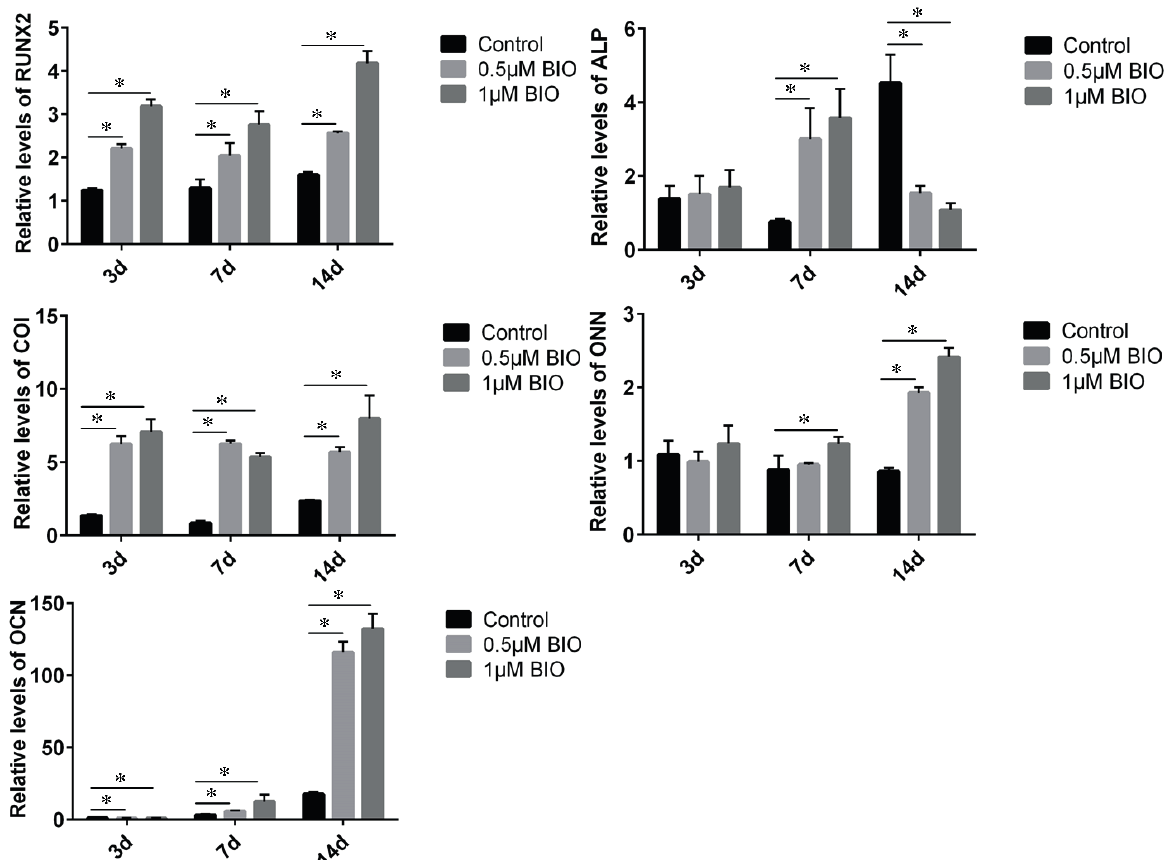
Figure 6 - BIO enhanced the mRNA expression of osteoblast differentiation markers in canine BMSCs. Canine BMSCs were incubated with osteogenic medium with or without BIO for 3 d, 7 d and 14 d, collected the cells and detected expression of RUNX2, ALP, COI, ONN, and, OCN mRNA by qPT-PCR . (n = 3). Error bars denote mean ± SD. *P < 0.05. Control: osteogenic medium; 0.5 and 1.0 μM BIO: osteogenic medium containing 0.5 and 1.0 μM